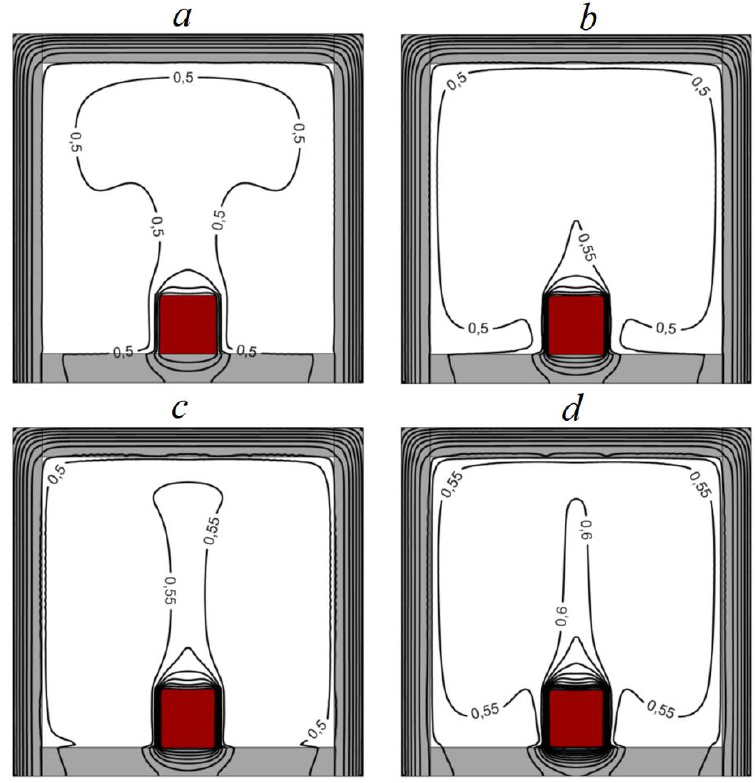
Figure 8. Isotherms Θ at 9 10 , 0.6 Ra : ( a ) Os = 0.1, ( b ) Os = 0.5, ( c ) Os = 1, and ( d ) Os = 2.